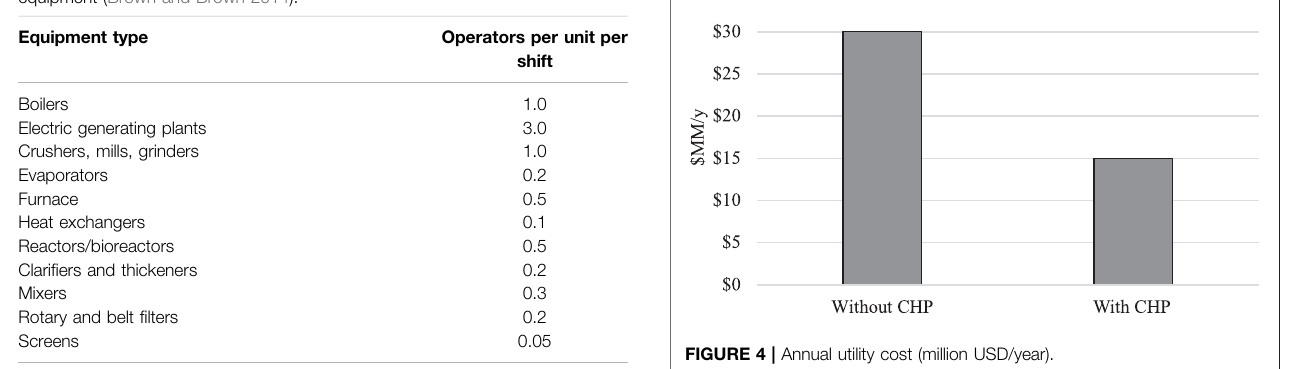
FIGURE 4 | Annual utility cost (million USD/year).